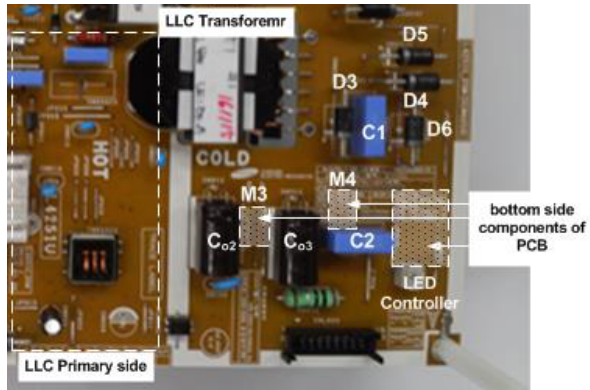
Figure 9. The prototype of the proposed LED driver.